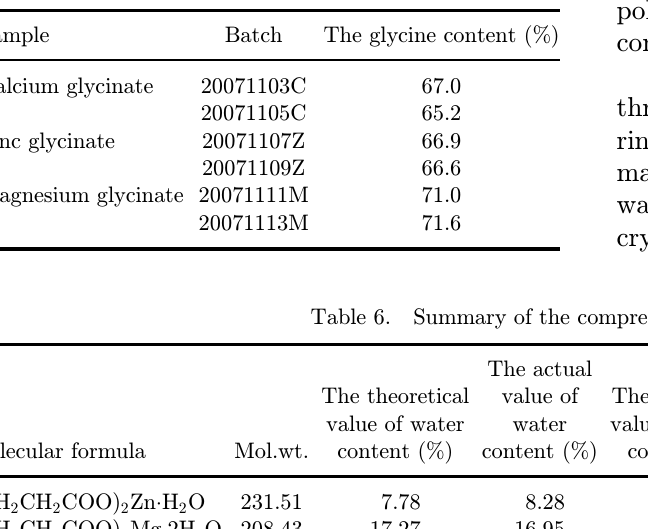
Table 5. The glycine contents of the three metal chelated glycinates.